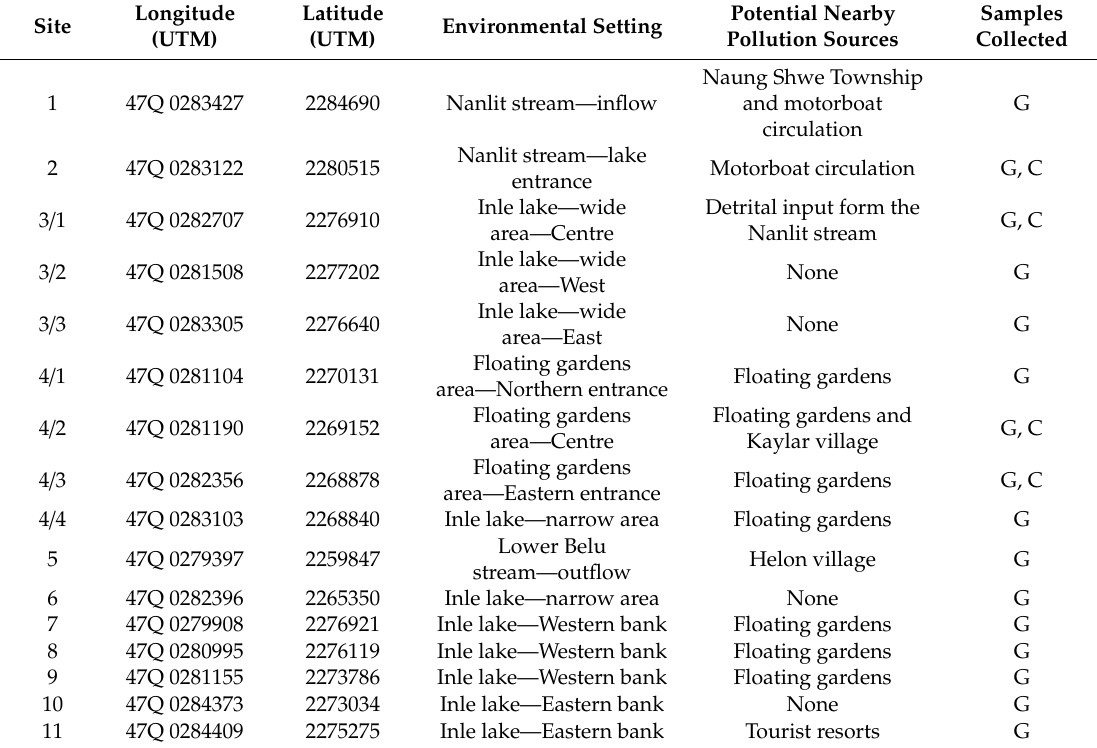
Table 1. Location, environmental setting, and potential pollution sources in proximity to the grab (G) and core (C) sediment samples reported in this